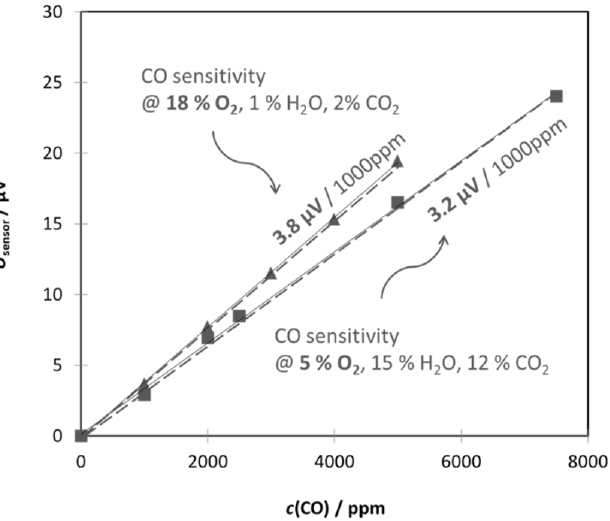
Figure 4. Typical characteristic dependency of the signal of a thermoelectric sensor; a linear relation between the sensor signal and the analyte is achieved. The characteristic is also affected by the base gas conditions such as oxygen concentration and humidity. The presented data of a Gen_1 sensor was derived in a lab measurement of synthetic gas without a protection cap.